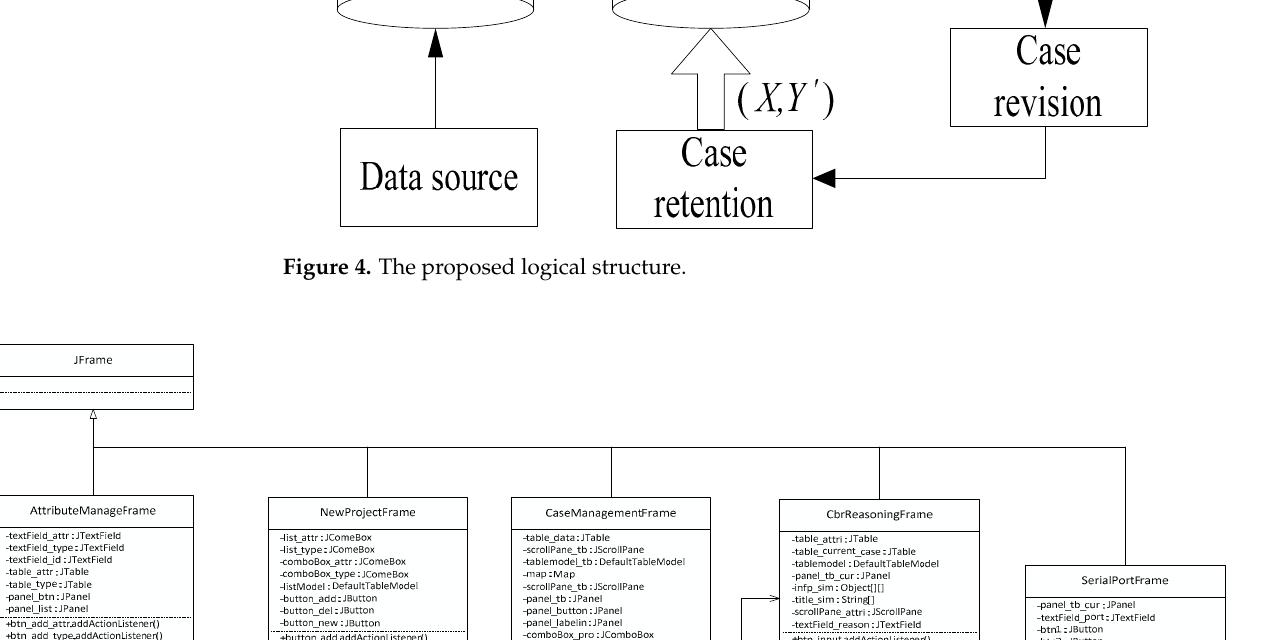
Figure 6. A snapshot of the CBR process.